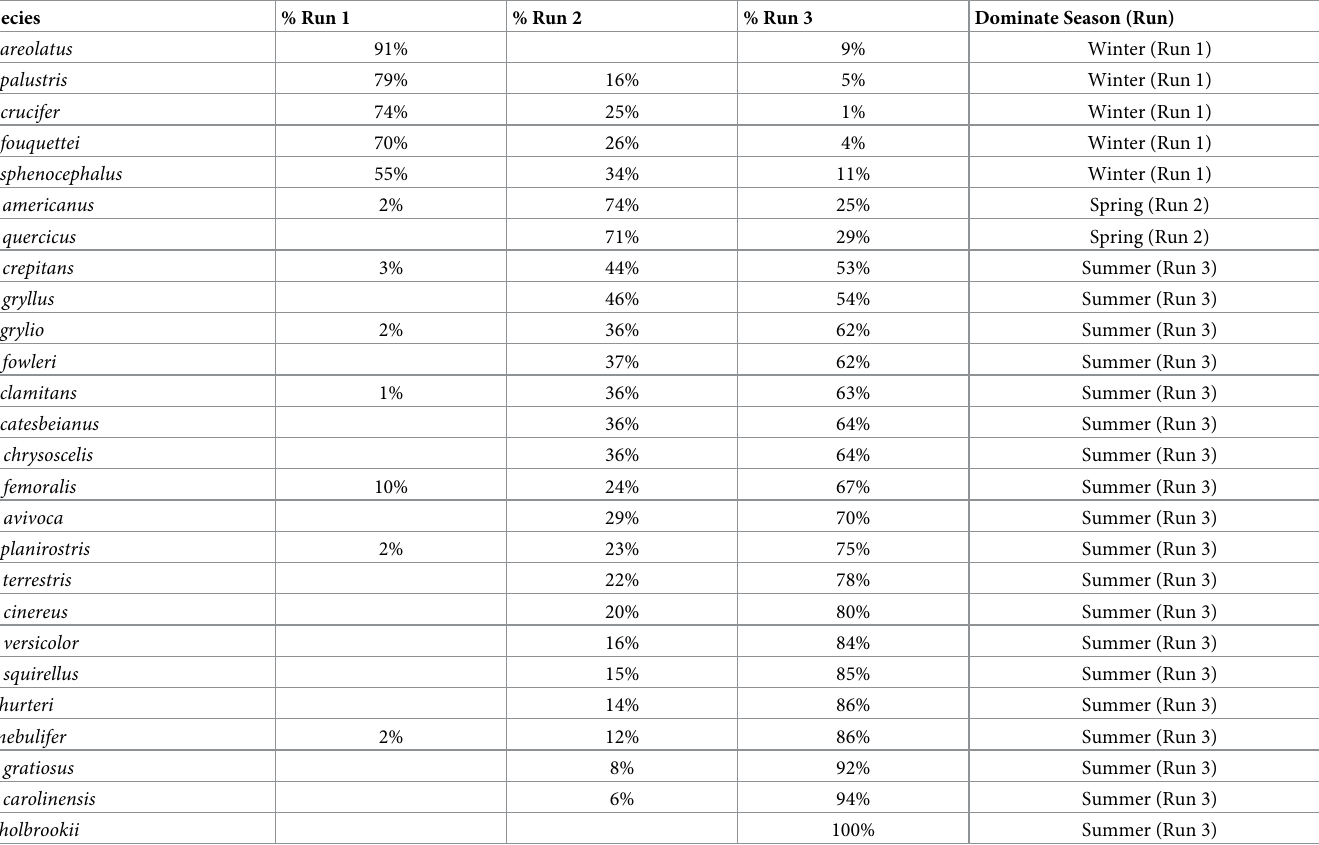
Table 4. Percentage observation by run.